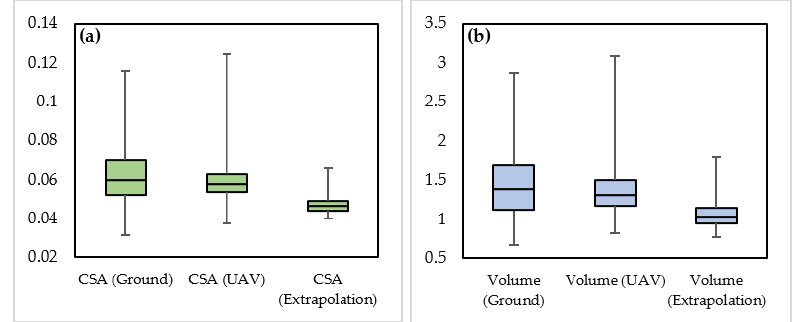
Figure 9. Box-and-whisker plots for comparison of the differences between the means of tree parameters: ( a ) CSA (m 2 ) ( b ) Volume (m 3 ) derived from different approaches. The medians of the measured values are marked by vertical lines inside the boxes. The ends of the boxes are the interquartile range (upper: Q3 and lower: Q1). The whiskers show the highest and lowest observations.